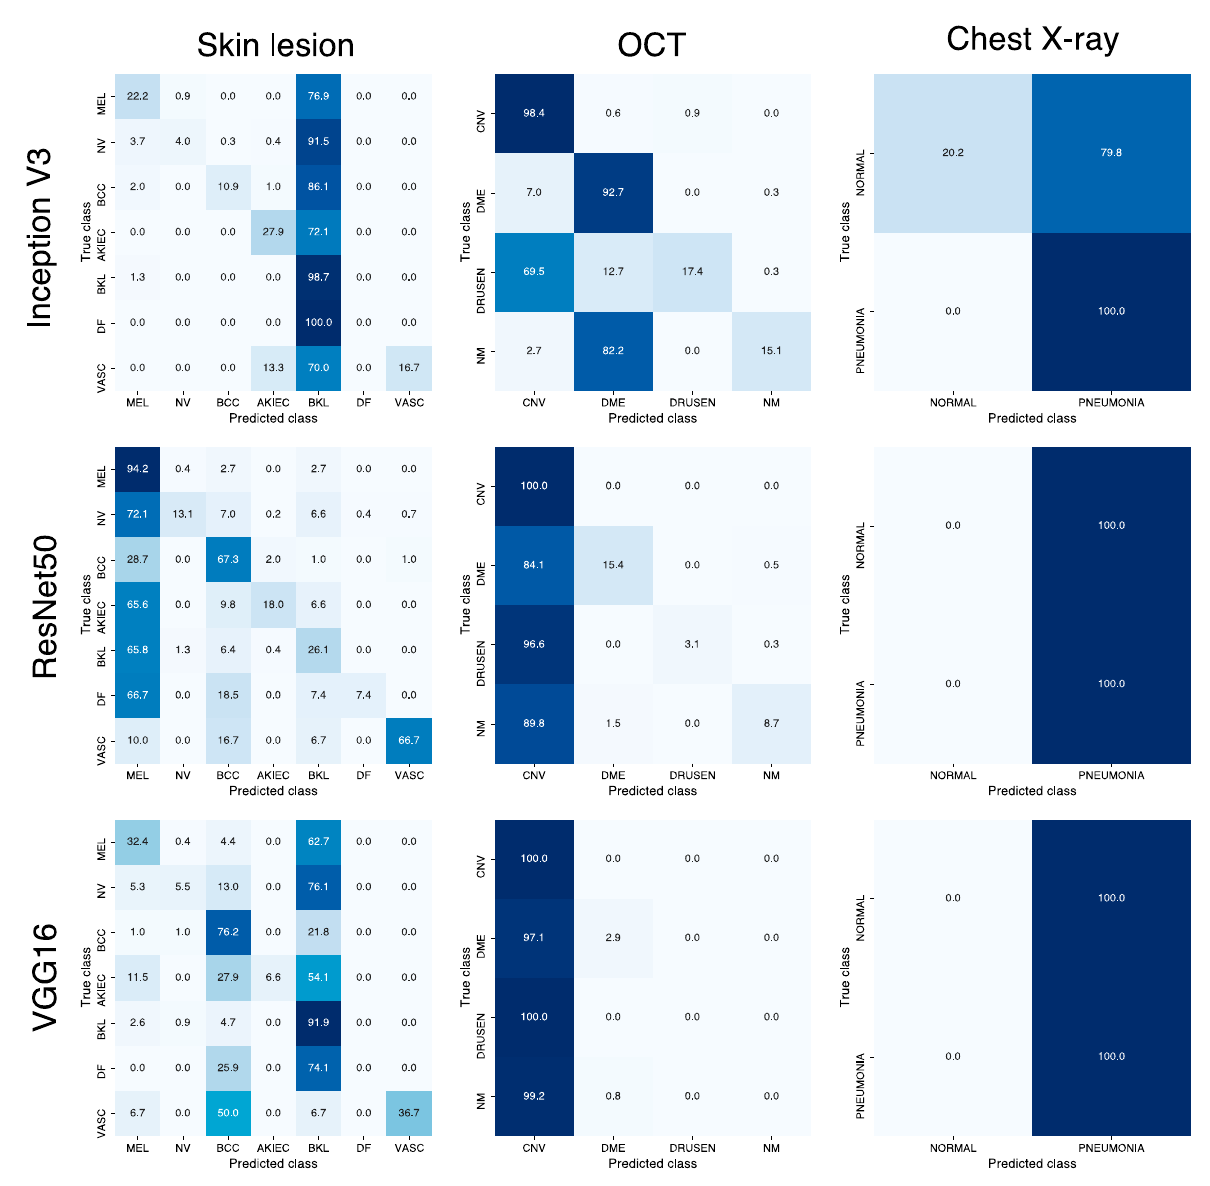
Figure 2. Normalized confusion matrices for Inception V3, ResNet50, and VGG16 models attacked using nontargeted UAPs for skin lesions, OCT, and chest X-ray image datasets. Here, 𝑝 = 2 for skin lesion and chest X-ray image datasets, and 𝑝 = ∞ for the OCT image dataset. See Table S1 for the abbreviations of the class labels.